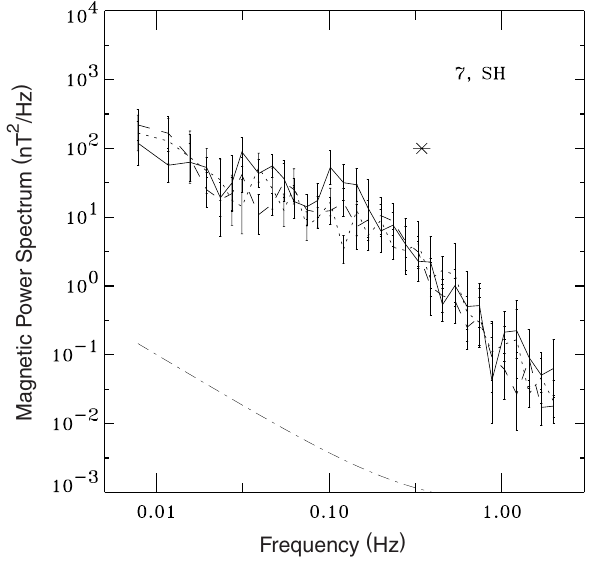
Fig. 8. Superposed-epoch analysis of magnetic spectra 7min down- stream of 9 quasi-perpendicular high- β bow shock crossings of which the mirror instability criterion is well satisfied. The dash-dot line at the bottom stands for the instrumental noise